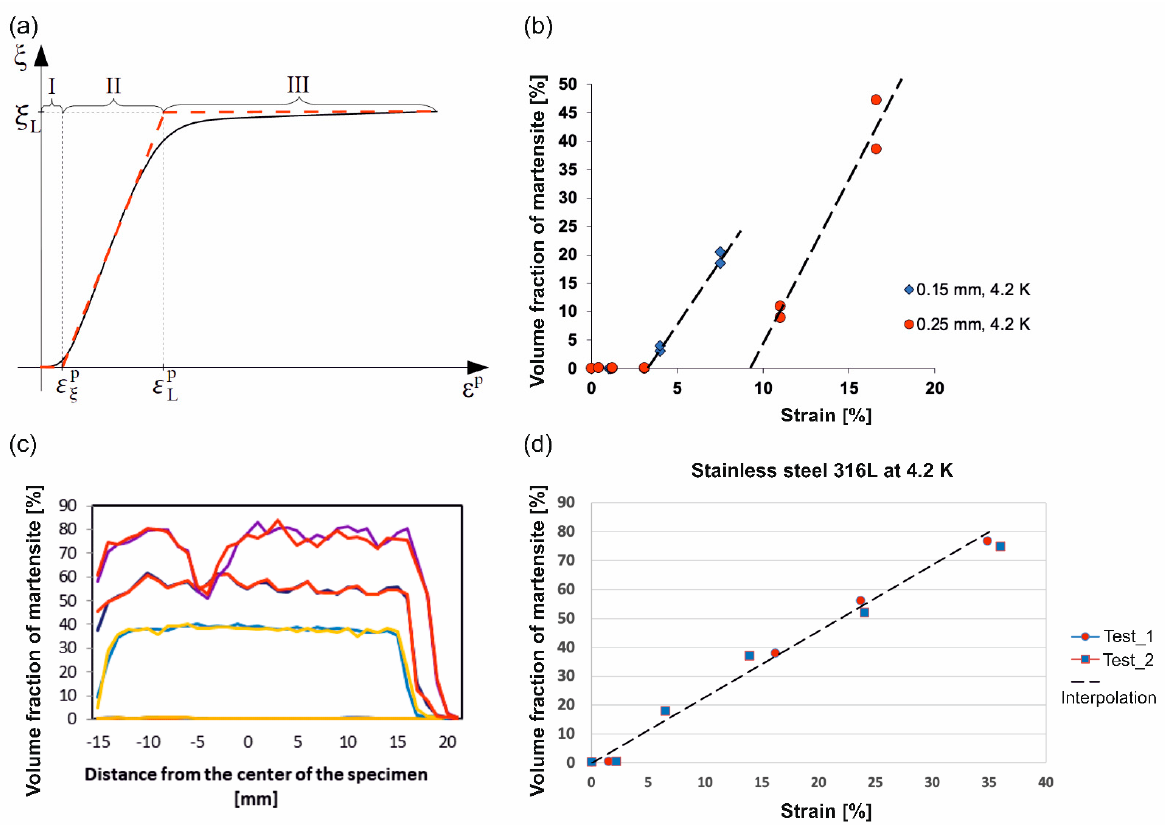
Figure 13. Volume fraction of martensite as a function of plastic strain: ( a ) schematic dependence, ( b ) magnetometer measurement for grade 316L stainless steel (Table 3) samples with different thickness, ( c ) martensite distribution along the sample axis for 316L steel defined in Table 1, as a basis for the relationship presented in graph ( d ). Table 3. Parameters of the material model.